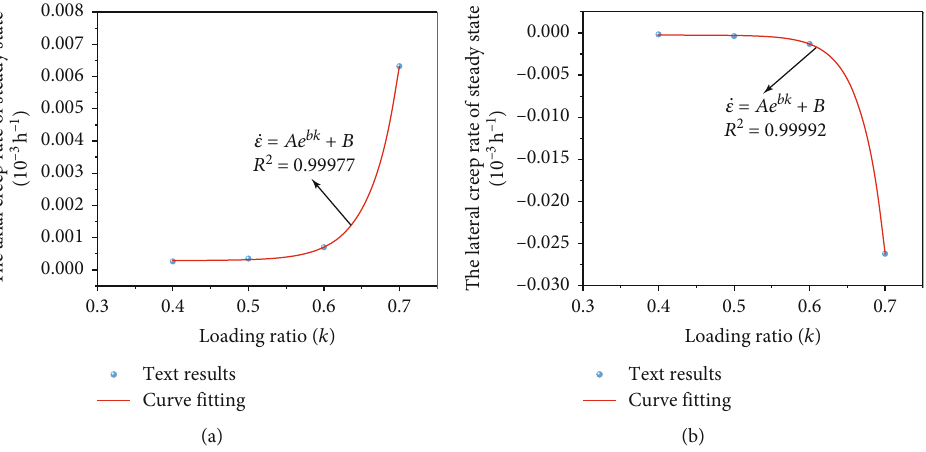
Figure 7: The relationship between steady-state creep rate and loading ratio of the mudstone